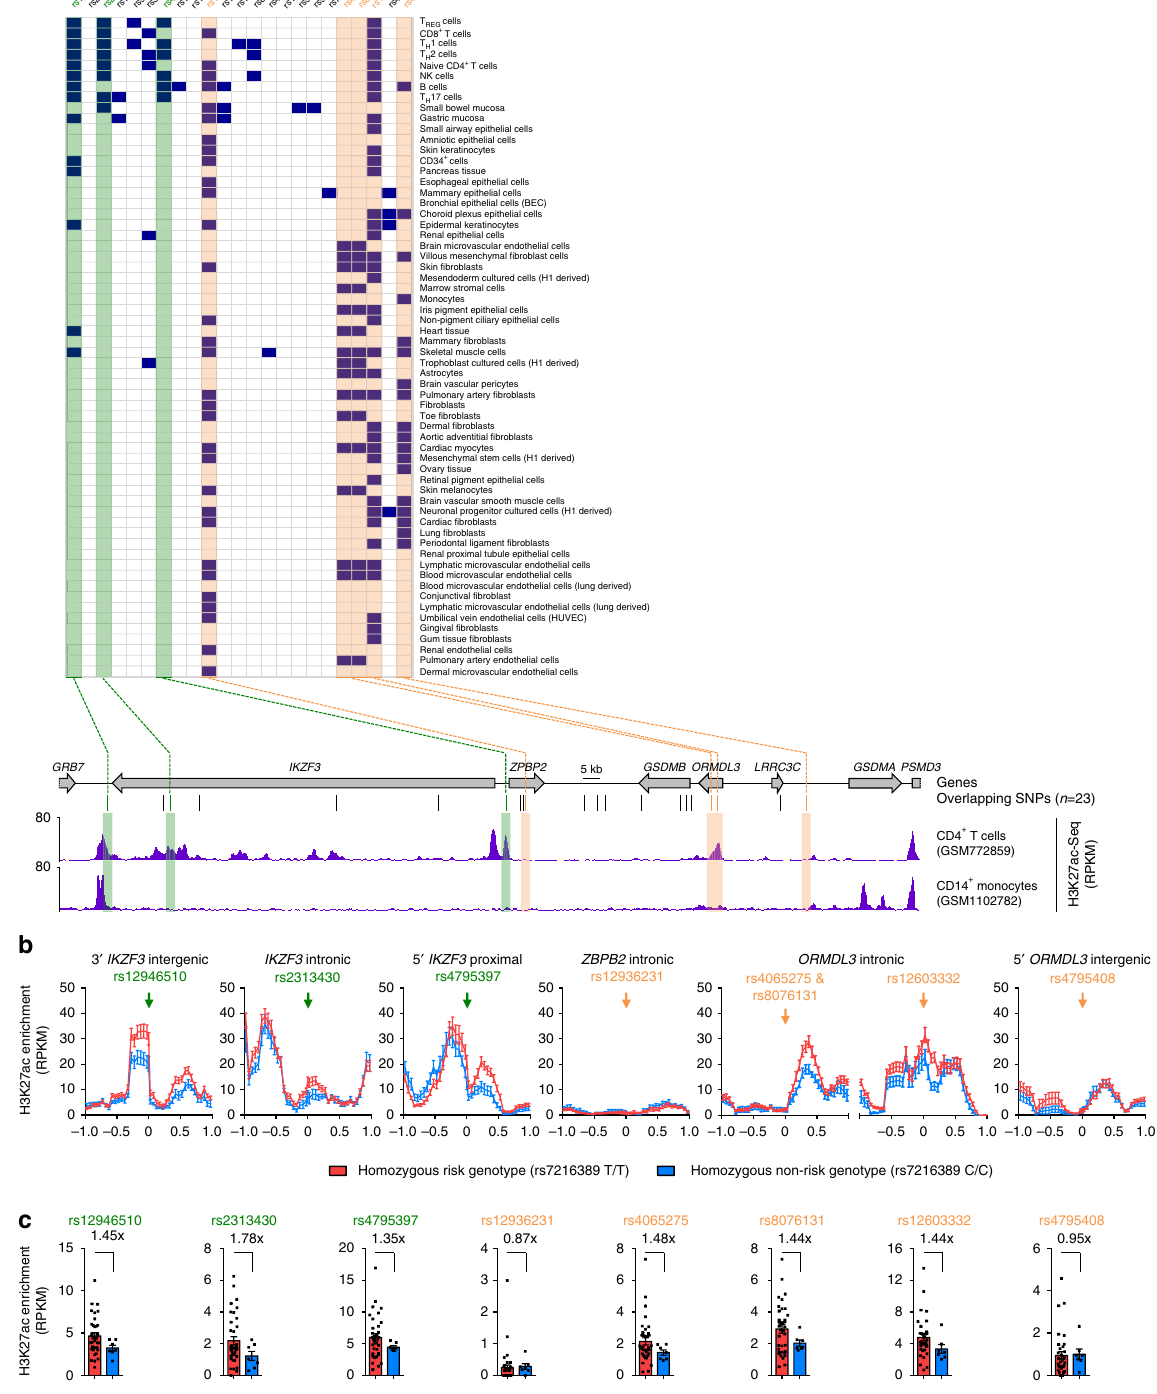
Figure 3 | 17q21 SNPs affect the function of an intronic enhancer in ORMDL3 . ( a ) 17q21 SNPs (columns) that overlap with DHS (shown in dark blue squares) in different primary cell types (rows), as described in Fig. 1e,f. Green boxes highlight SNPs that overlap DHS enriched in lymphocytes and orange boxes highlight SNPs that overlap DHS in many immune and non-immune cell types. Bottom panel shows UCSC tracks of the 17q21 locus, along with asthma-associated SNPs that overlap DHS. H3K27ac enrichment tracks of CD4 þ T cells and CD14 þ monocytes (from NIH Epigenomics Roadmap) are shown below. Boxes highlight SNPs of interest that overlap DHS. ( b ) Tracks showing comparison of average H3K27ac enrichment values (RPKM) (in each 50-bp window spanning 1kb region on either side of the SNPs of interest) between homozygous risk (rs7216389 T/T, n ¼ 36) and non-risk (rs7216389 C/C, n ¼ 7) samples. Arrow indicates location of the SNP; error bars are mean ± s.e.m. ( c ) H3K27ac enrichment values for a 200-bp region around the indicated asthma-risk SNP. Each dot represents data from a single assay; error bars indicate mean ± s.e.m.; numbers indicate average fold change in H3K27ac enrichment between carries with risk and non-risk allele.